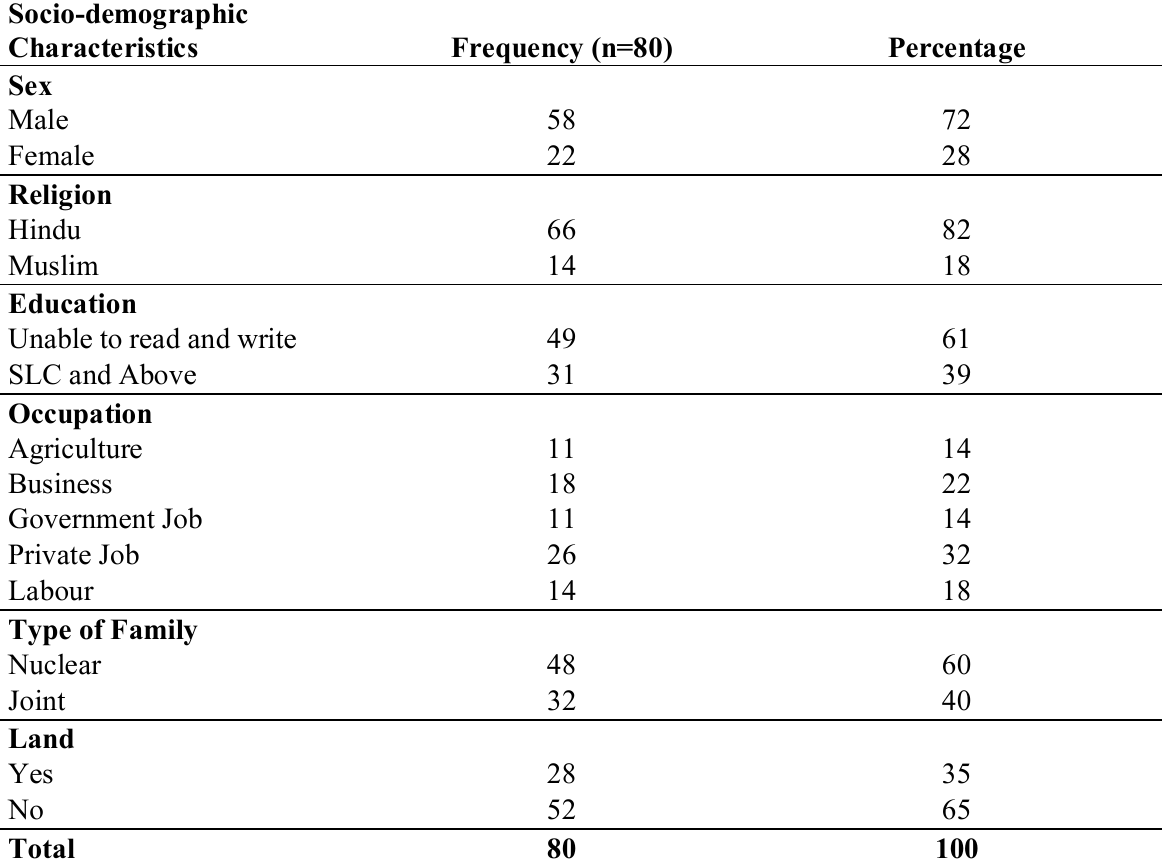
Table 1. Socio-Demographic Characteristics of the Respondents